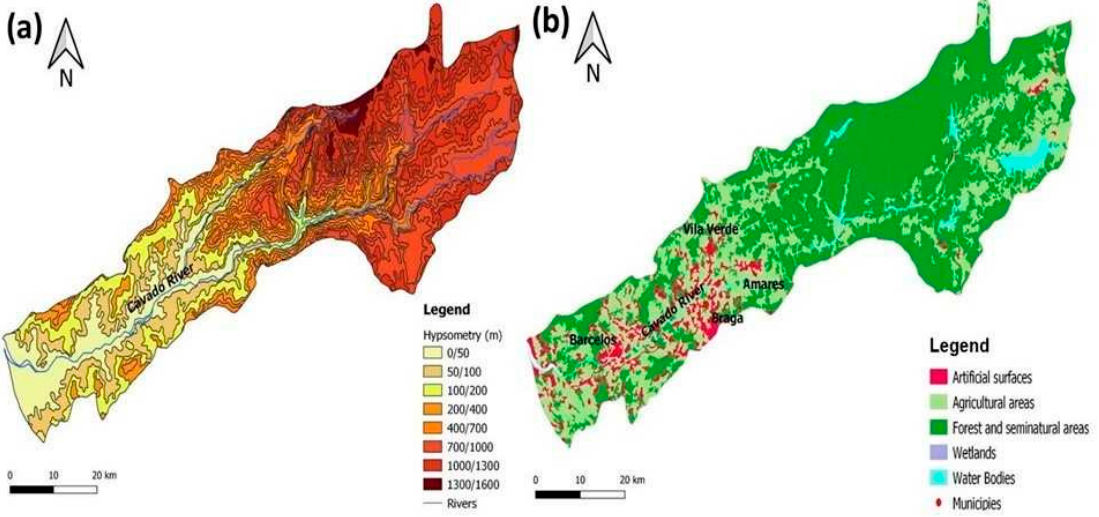
Figure 2. Cávado River watershed: ( a ) hypsomety and ( b ) land use (adapted from Reference [20]).